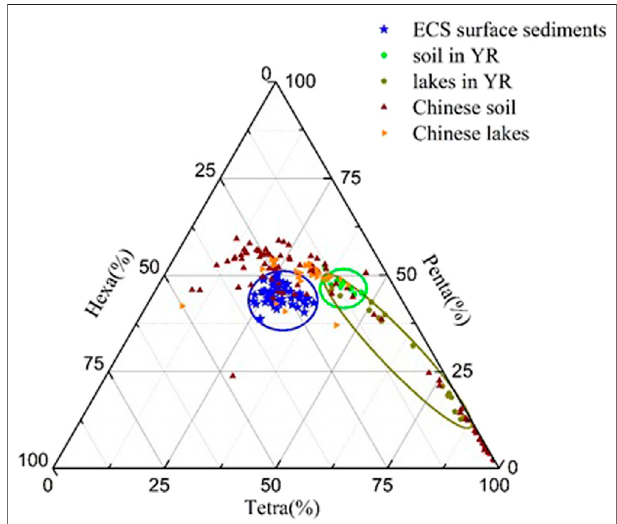
FIGURE 3 | Abundances of tetramethyl, pentamethyl, and hexamethyl brGDGTs of surface sediments of the ECS continental shelf, Chinese soil, Chinese lakes, lakes, and soils in the Yangtze River catchment (Xie et al., 2012; Yang et al., 2014; Dang et al., 2018).